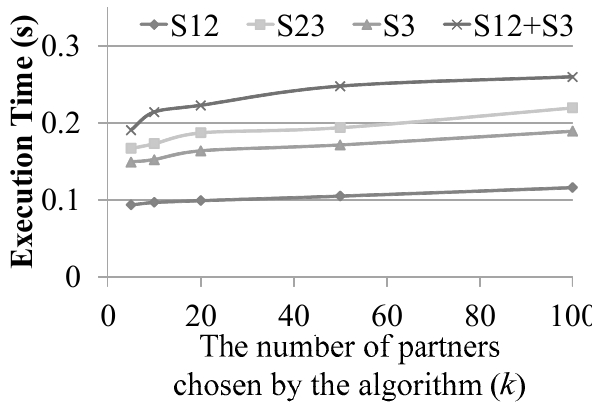
Figure 10. Execution time of different response strategies.